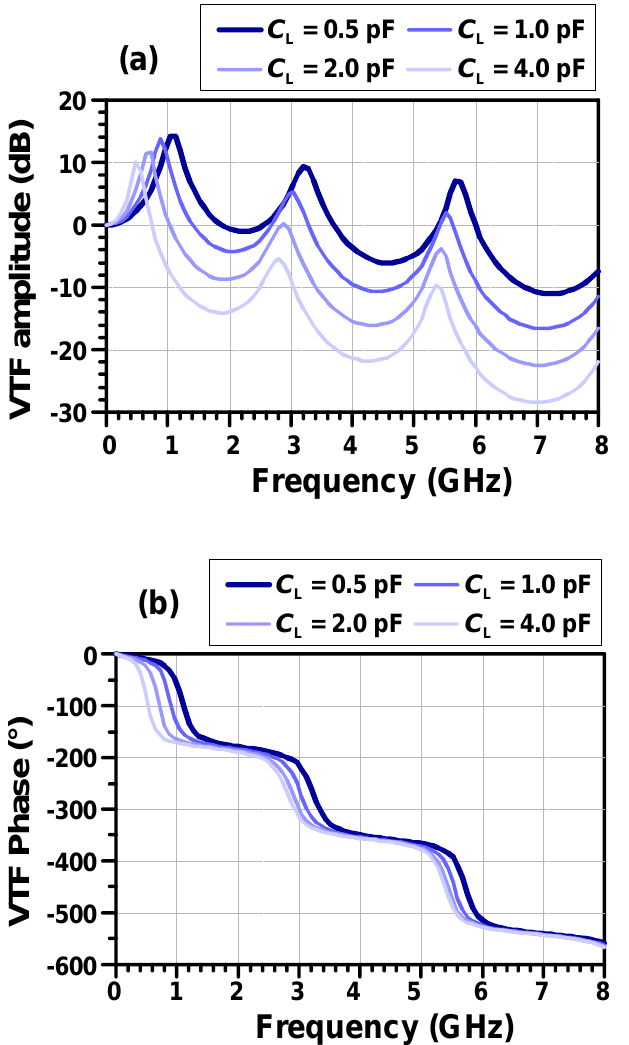
Figure 11: Frequency responses versus load C L for the magnitude (a) and the phase (b) of the VTF for case 1.